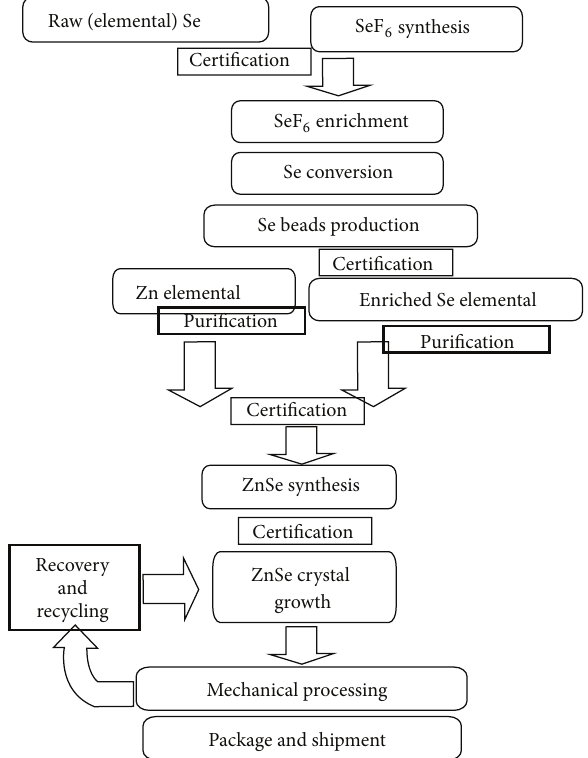
Figure 7: Production diagram of enriched ZnSe crystals. 65% (35% irrecoverable loss of enriched ZnSe), it comes out that the total expected enriched crystal mass is 16.9 kg (8.9 kg